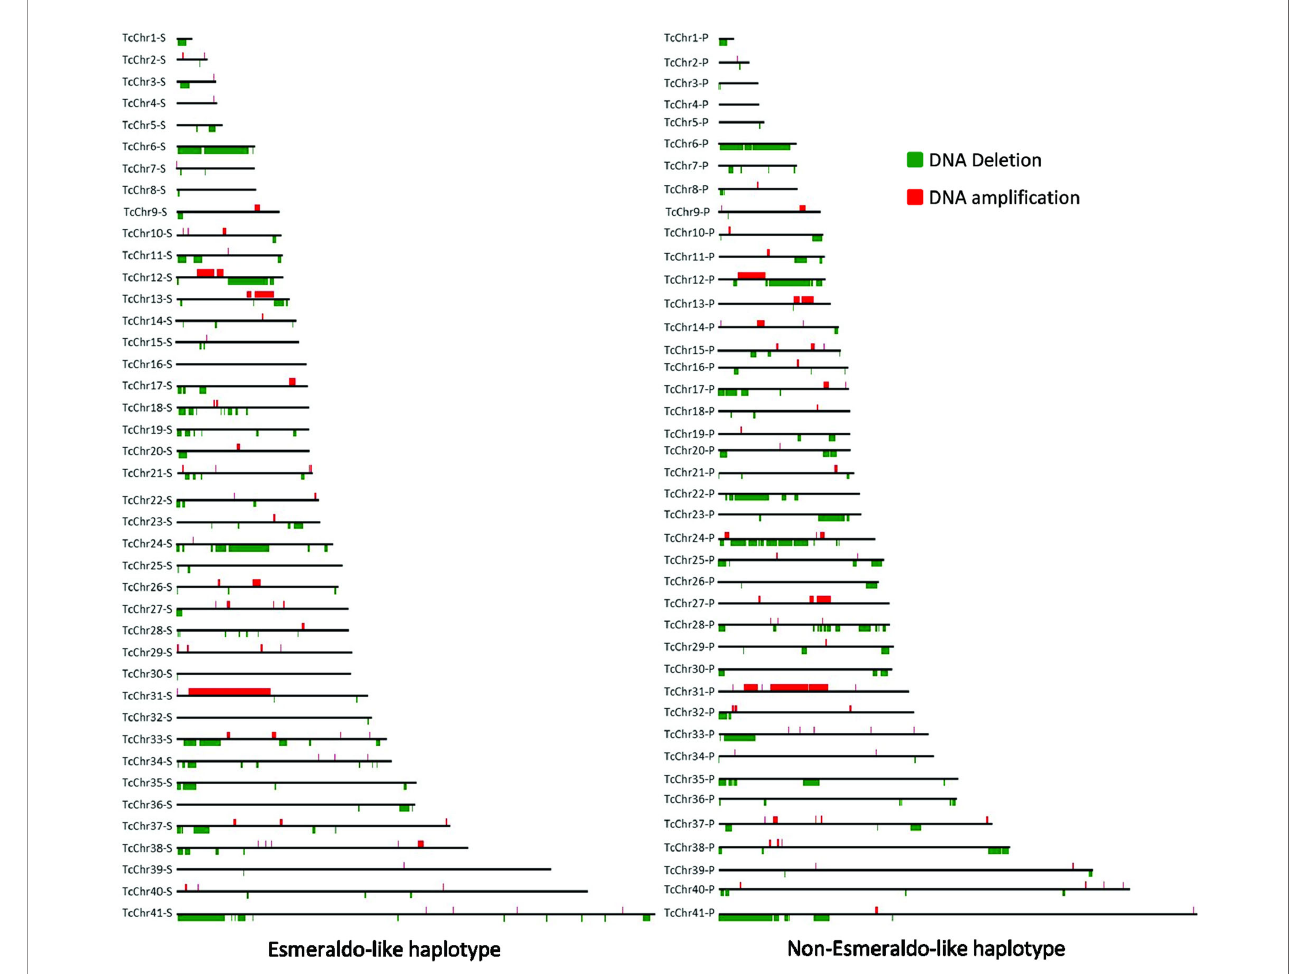
FIGURE 1 | Distribution of CNVs across T. cruzi chromosomes. Chromosomal alterations identi fi ed in clone D11 were mapped on both haplotypes (S, Esmeraldo- like and P, Non-Esmeraldo-like) on each in silico chromosome of the CLB reference genome (Weatherly et al., 2009). In silico chromosomes of CLB are numbered 1 to 41, from the smallest, TcChr1 (0.77 Mb), to the largest, TcChr41 (2.37 Mb). Ampli fi cation and deletion regions are represented in red and green, respectively. Chromosomes and recombination events are represented to